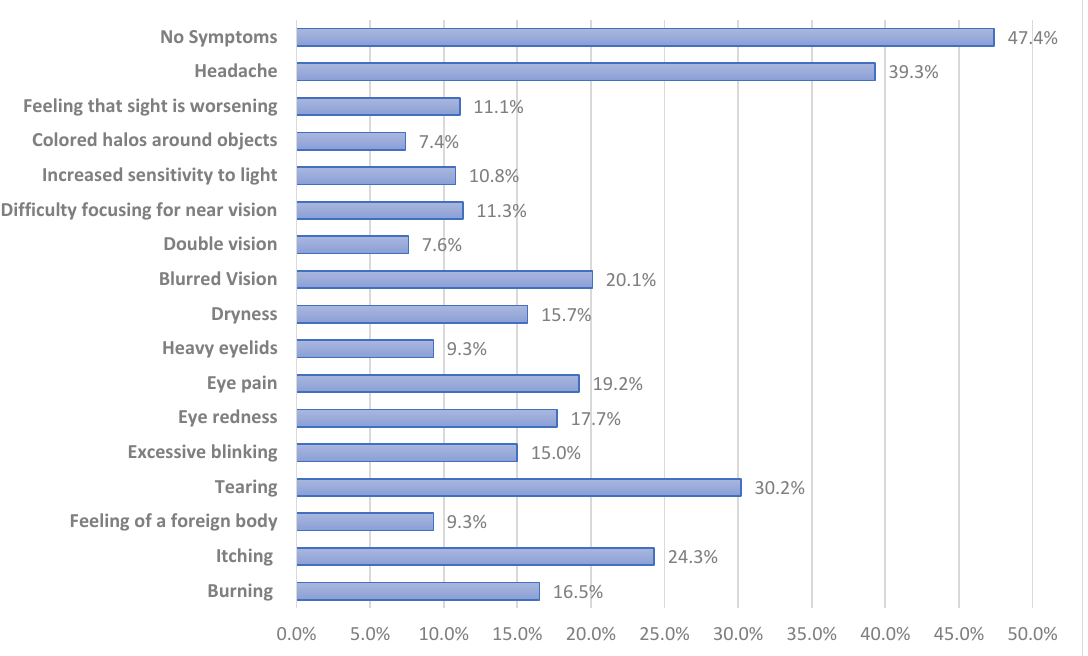
Figure 1. Frequency of eye symptoms reported during COVID-19.